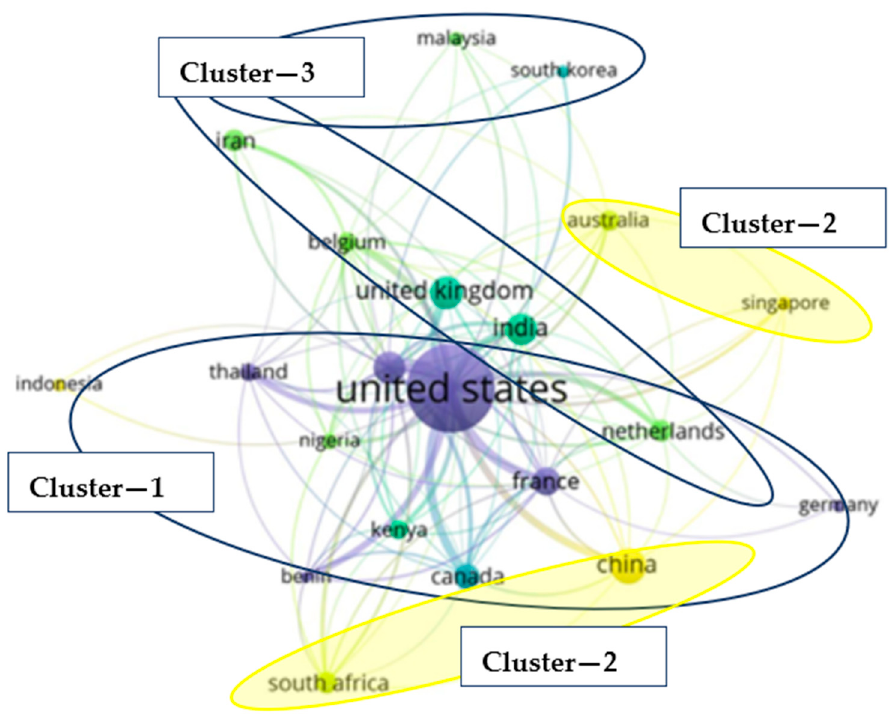
Figure 5. Top 20 countries’ contribution to VSCM.